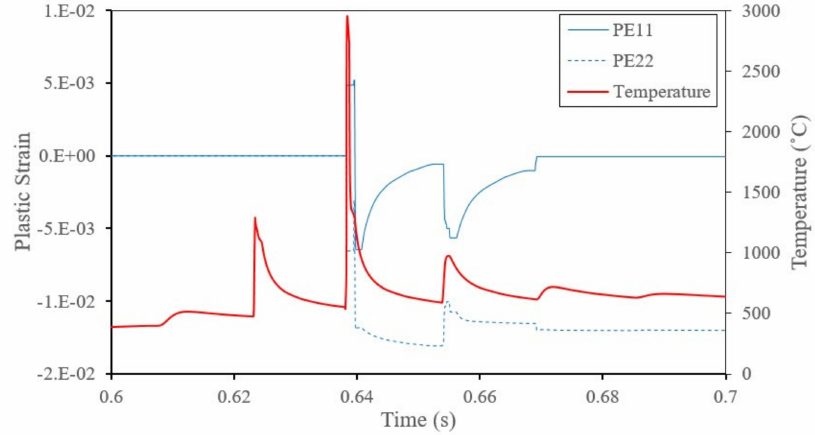
Figure 22. Plastic strain and temperature evolution at 220 W, 650 mm/s, and 0.12